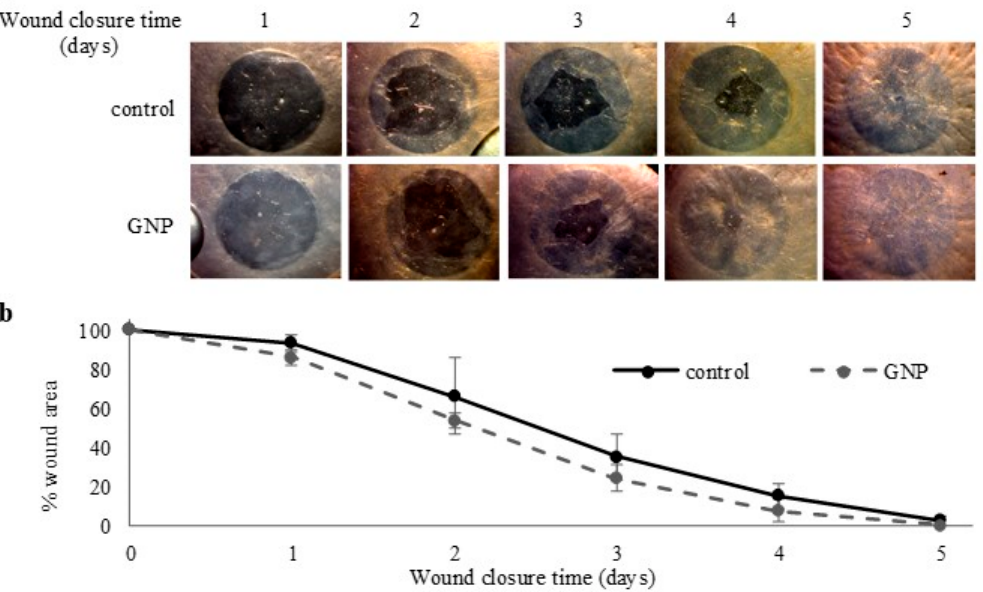
Figure 4. Impact of GNP on the wound closure properties of hTECs. ( a ) Pictures of hTECs wounds according to the closure time (one representative hTEC out of four is shown for each goup). hTECs were wounded and maintained in culture medium supplemented with or without GNP 2000 (50 µL droplet of culture medium containing 88 nM GNP 2000 added each day). Remaining wound surface was measured using ImageJ software. ( b ) Wound surface (%) remaining for each condition (control or GNP 2000) were determined at each day (1 to 5) and plotted on graph. Control wounded hTECs were exposed solely to the vehicle (DMSO).